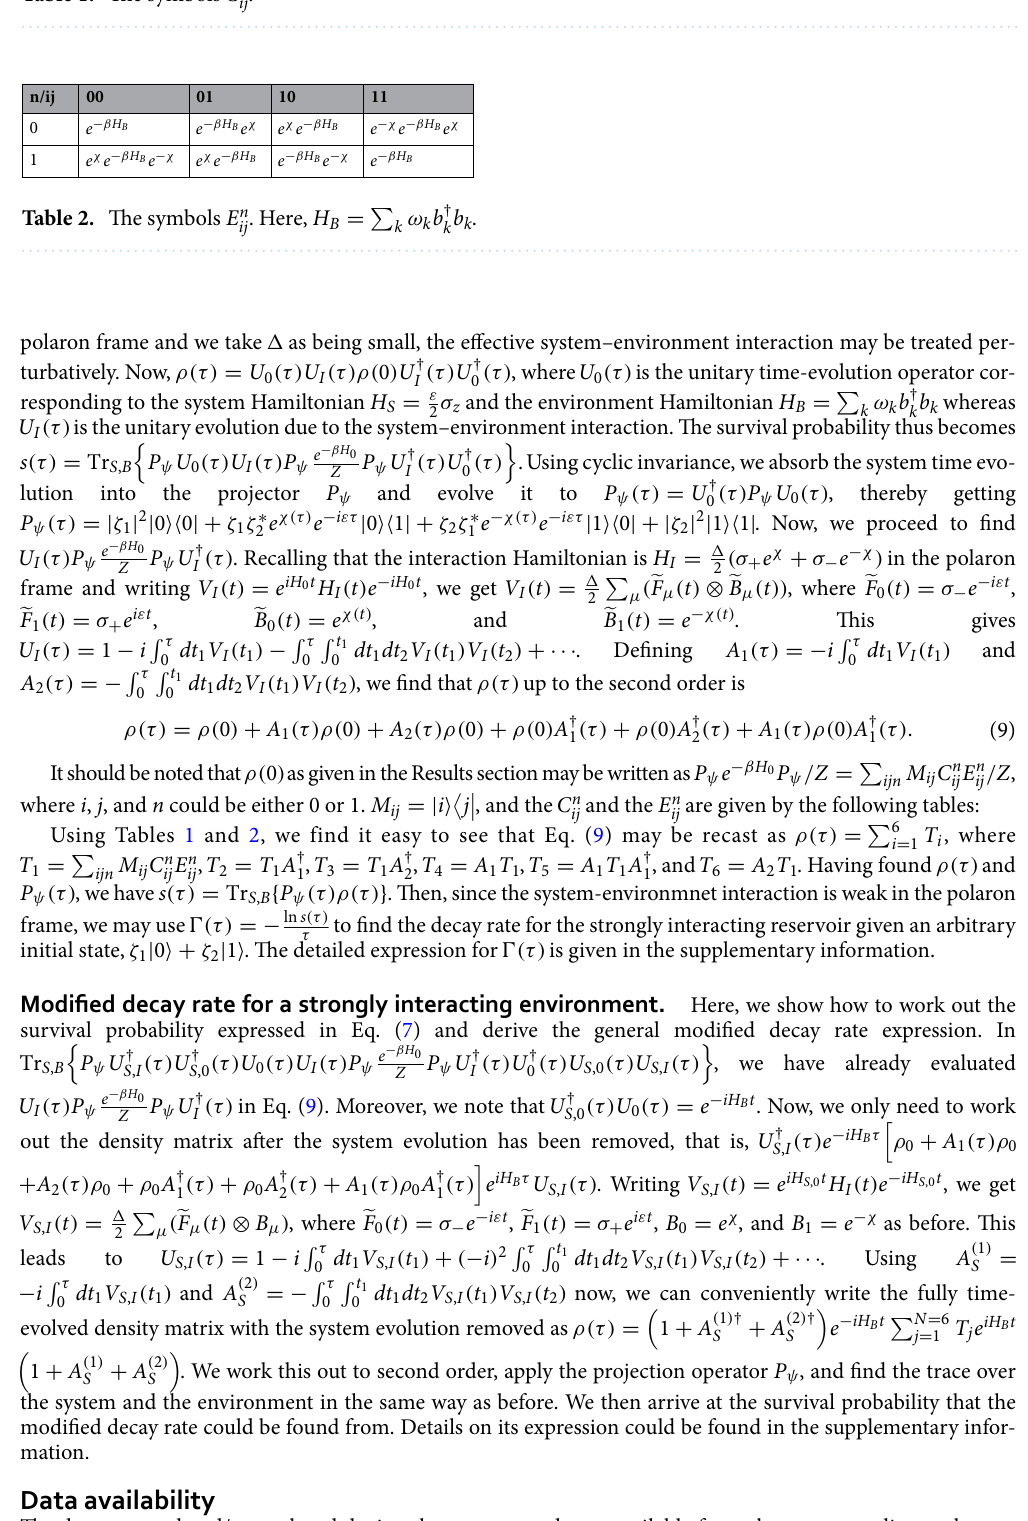
Table 1. The symbols C n ij .